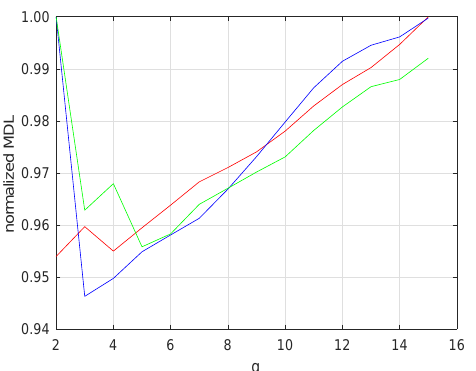
Figure 9. MDL index computed for the East antenna time series in the pre-discontinuity period. East (red line), North (green line) and Up (blue line) components